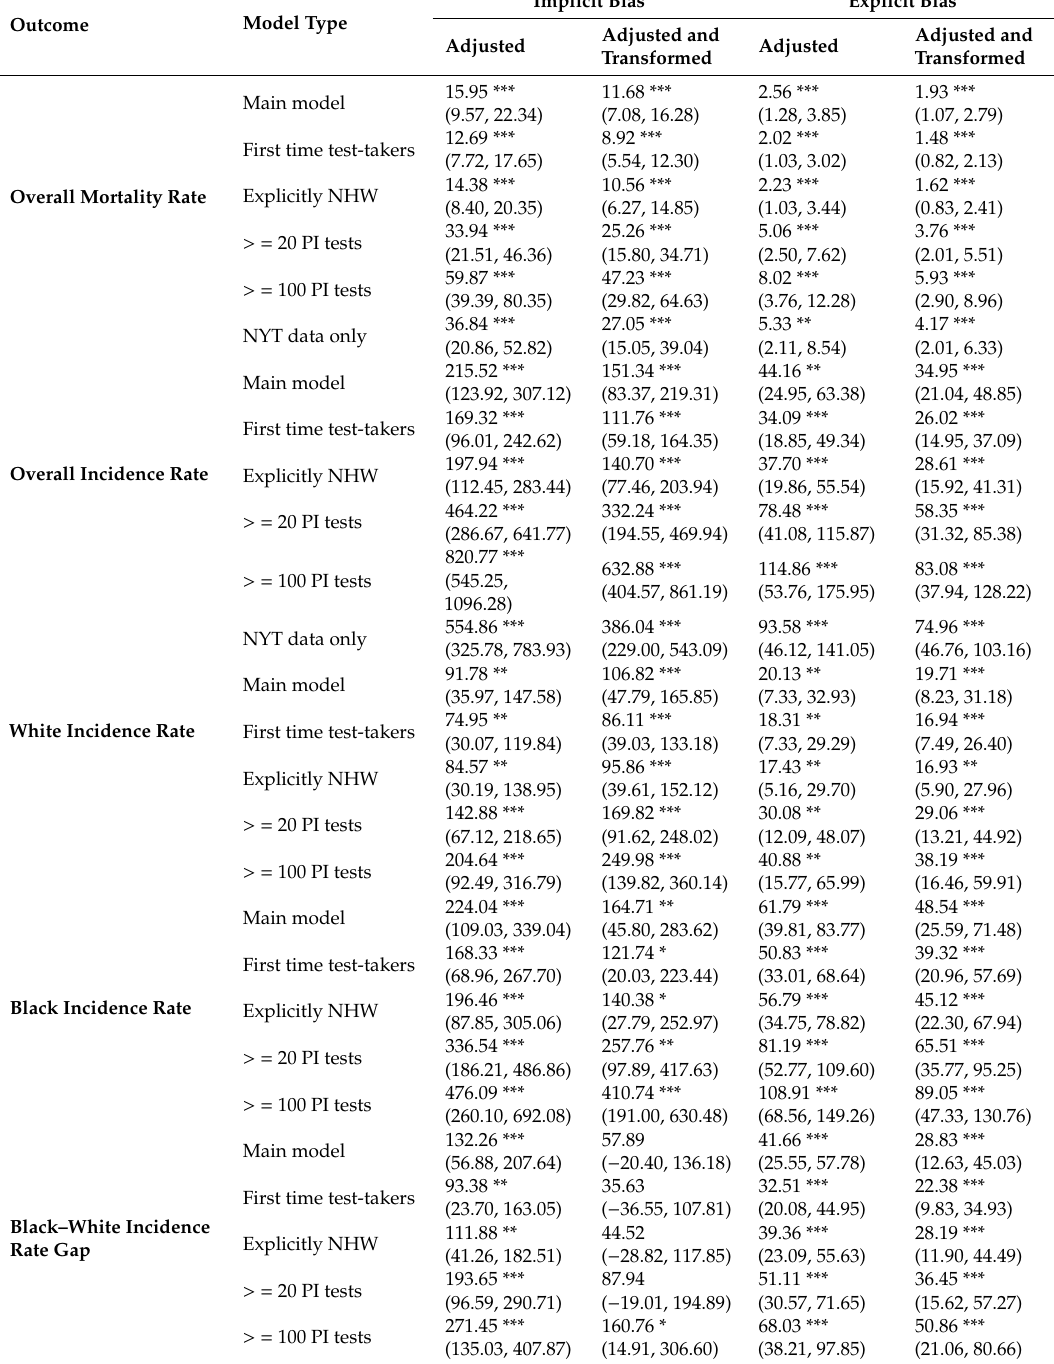
Table A6. Complete sensitivity